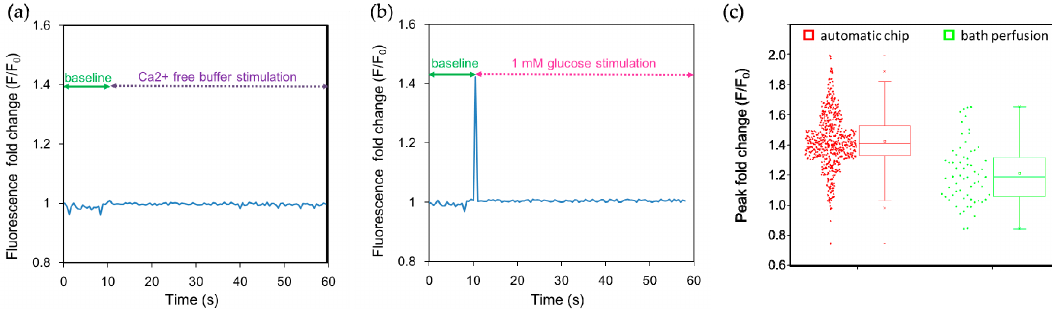
Figure 3. Human L cell line NCI-H716 cells were stimulated in the automated microfluidic chip with the sweet tastant. ( a ) Ca 2+ -free buffer was introduced as a control; no peak in the fluorescence fold change was observed after stimulation; ( b ) Then 1 mM glucose solution was introduced at 10 s, and a peak in the fluorescence intensity associated with an increase of intracellular calcium concentration rapidly appeared; ( c ) Peak fold changes in the fluorescence intensity indicate heterogeneity in calcium responses of single cells. The average peak fold change was 1.39 obtained using the automated platform ( n = 1382) and 1.21 obtained using the bath perfusion system ( n = 64), respectively. The difference in peak fold changes was significant ( p < 0.001) as determined by the two-tailed Student’s t -test. Cohen’s effect size value ( d = 0.65) suggested a moderate to high practical significance.